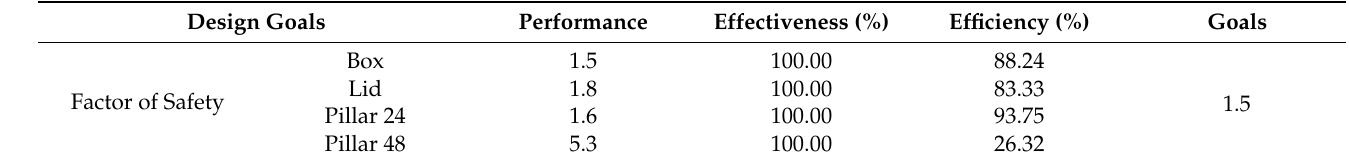
Table 11. Mechanical design FOS goals — visual scorecard.